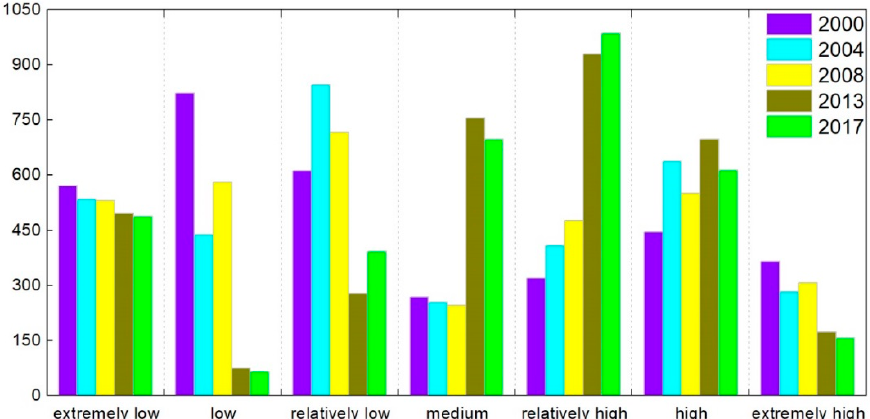
Figure 8. Changes in the areas of different ecological risk grades from 2000–2017. Based on the analysis of the ecological risk level of open coastal wetlands in Jiangsu, the area occupied by the ecological risk grades of 106 risk communities in the study area were analyzed statistically.